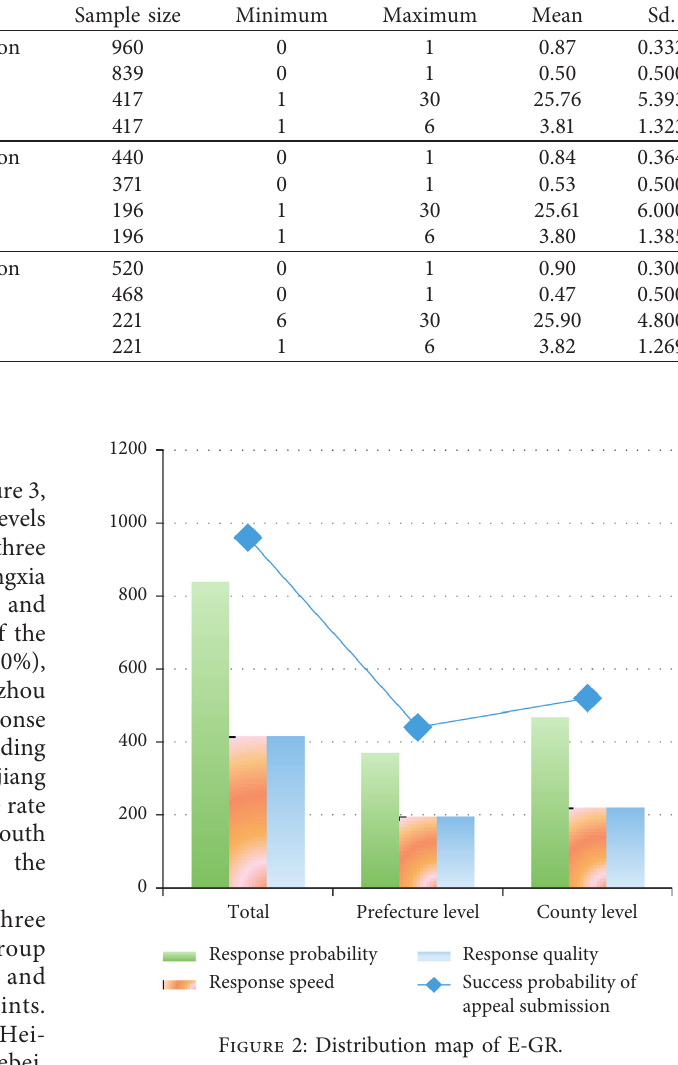
Table 4: Descriptive statistics of E-GR.